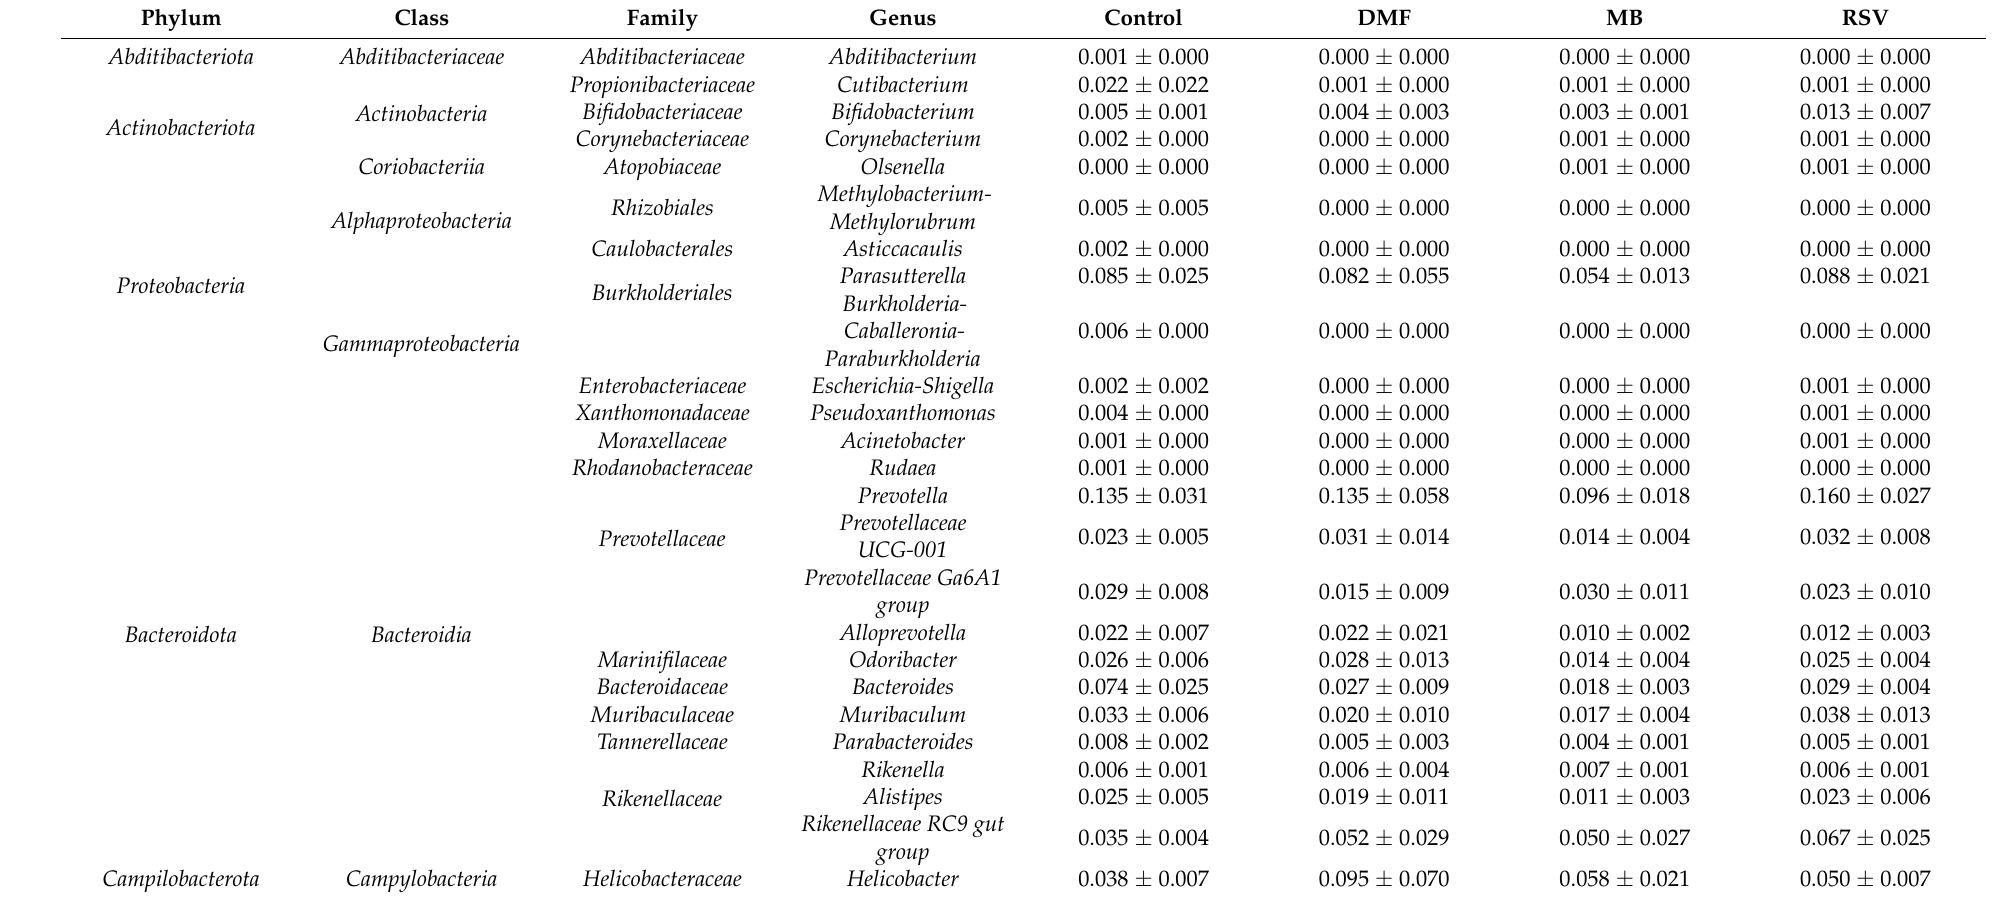
Table 7. Gut microbiome